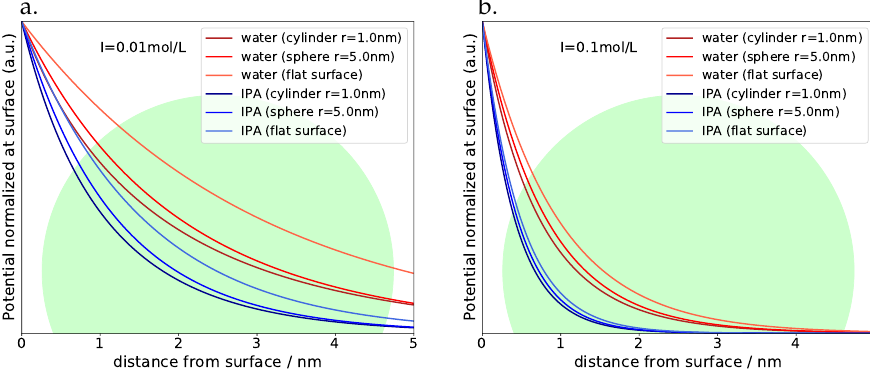
Figure 2. Potential screening at room temperature depending on geometry and nature of solvent (IPA: isopropyl alcohol) at ( a ) ionic strength of 0.01 mol/L ( b ) ionic strength of 0.1